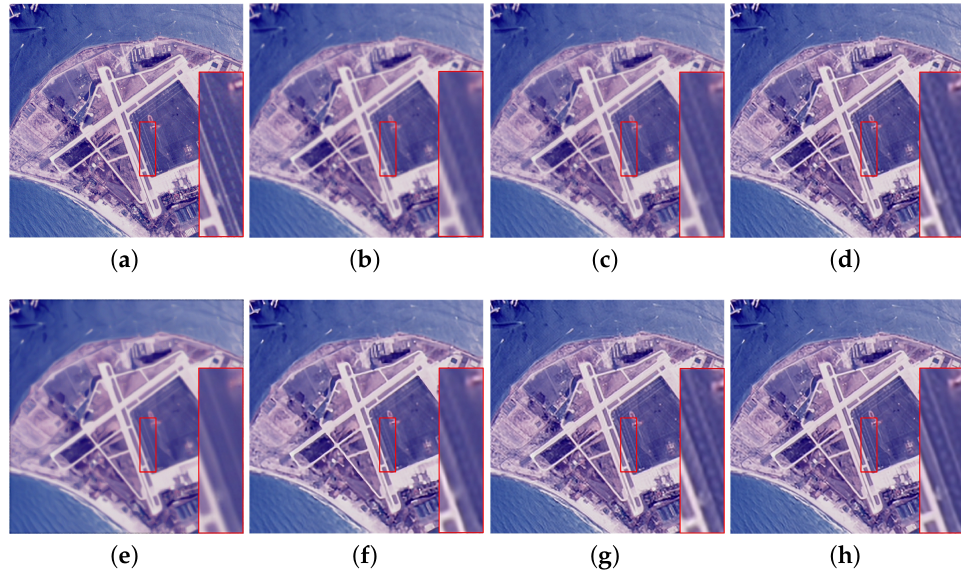
Figure 5. Visual comparisons of the proposed method and other methods on the aerial image (noise = 0). ( a ) original image. ( b ) Bicubic interpolation (PSNR:24.67, SSIM:0.6537, ERGAS:3.9962). ( c ) SRSC